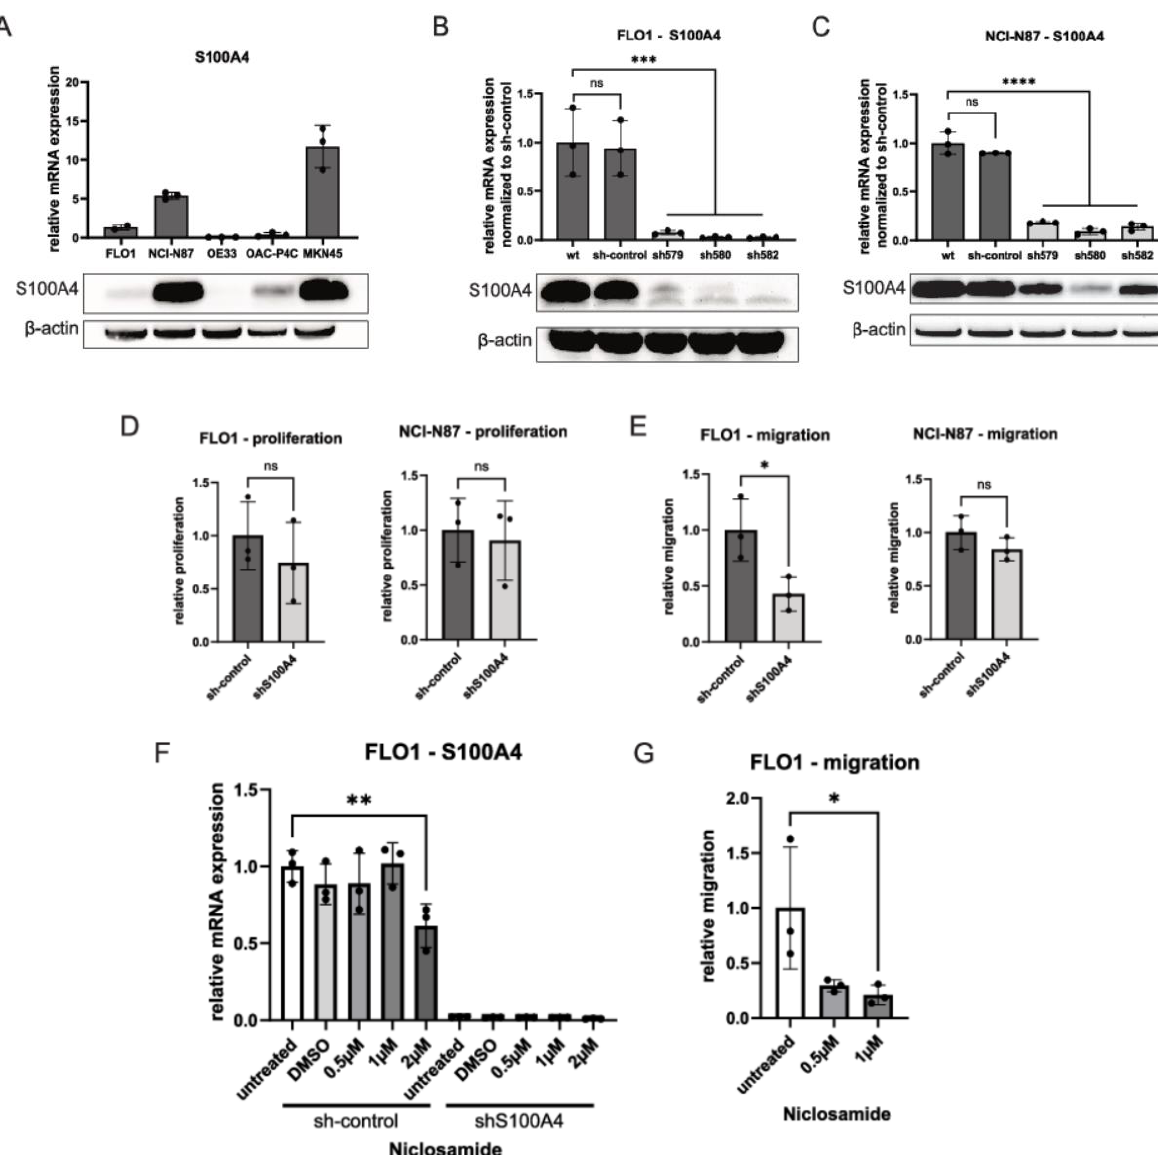
Figure 4. S100A4 in vitro phenotyping and functional assays. ( A ) Endogenous S100A4 expression levels (mRNA and protein) of four cell lines of Caucasian origin (FLO1, NCI-N87, OE33, OAC-P4C) and one of Asian origin (MKN45). ( B ) mRNA and protein expression levels of stable shRNA knock- down of S100A4 in FLO1 cell line with three different constructs, a control construct (sh-control) and non-transduced cells (wt). Maximum reduction in construct sh582 (97.3%, p = 0.0005). ( C ) mRNA and protein expression levels of stable shRNA knock-down of S100A4 in NCI-N87 cell line with three different constructs, a control construct (sh-control) and non-transduced cells (wt). Maximum reduction in construct sh580 (90.9%, p < 0.0001). ( D ) Relative proliferation of sh-control compared to the most effective knock-down line for FLO1 and NCI-N87 cell line. ( E ) Relative migration of sh-control compared to the most effective knock-down line for FLO1 and NCI-N87 cell line. Knock-down reduced migration in FLO1 cell line by 57.1% ( p = 0.0357). ( F ) Relative S100A4 mRNA expression after treatment of FLO1 derived lines sh-control and shS100A4 with niclosamide (0.5 µ M, 1 µ M and 2 µ M), untreated or treated with vehicle (DMS0). 2 µ M treatment reduced S100A4 expression in sh-control compared to untreated control (reduction of 38.72%, p = 0.0023). ( G ) Sh-control cells of FLO1 cell line show reduced migration upon treatment with niclosamide (0.5 µ M, 1 µ M; reduction untreated vs. 1 µ M: 79.1%, p = 0.0430), n = 3 for all experiments. ****: p < 0.0001, ***: p = 0.0001–0.001, **: p = 0.001–0.01, *: p = 0.01–0.05, ns: p ≥